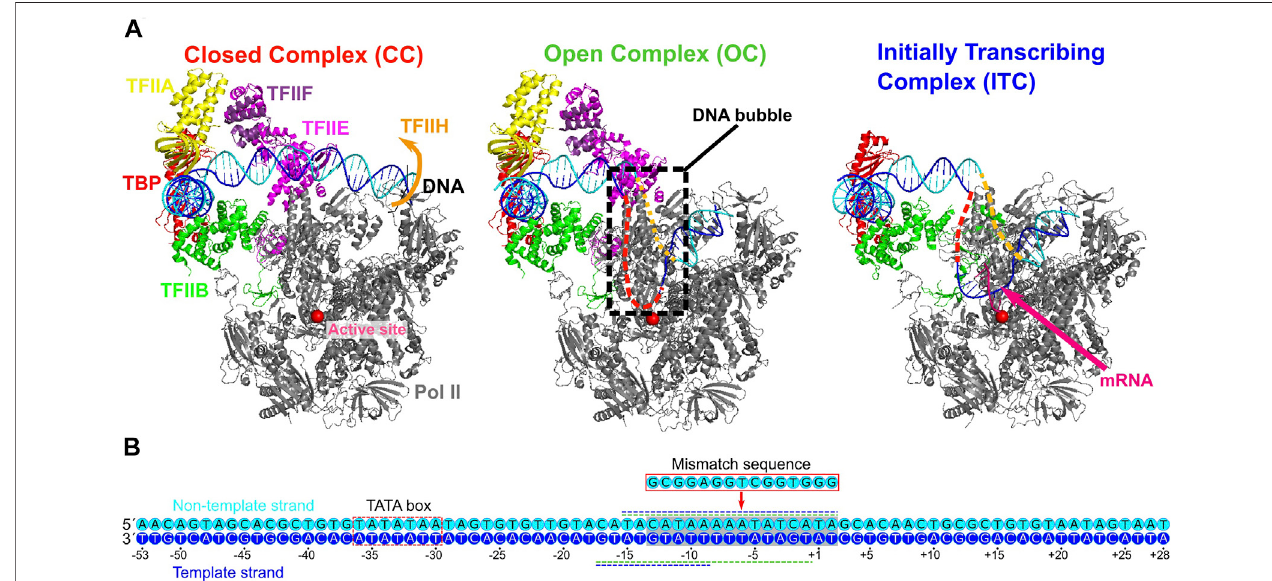
FIGURE 1 | Three yeast PICs of RNA polymerase II and the promoter sequence used. (A) The three PICs obtained by cryo-EM; the closed complex (CC) (PDB: 5FZ5) (left) ,theopencomplex(OC)(PDB:5FYW) (center) ,andtheinitiallytranscribingcomplex(ITC)(PDB:4V1N) (right) .TheCCandOCmodelscontainthepromoter DNA, Pol II, TBP, TFIIA, TFIIB, TFIIE, and TFIIF. The ITC model contains the promoter DNA, Pol II, TBP, TFIIB, and 6 bp nascent RNA. Parts of the melted DNA were not modeledintheOCandITCstates(Redandorangebrokenlines). (B) ThepromoterDNAsequenceusedinthecurrentstudy(numberedrelativetothetranscription starting site). The sequences are taken from those used in the cryo-EM studies of the OC and the ITC (Plaschka et al., 2016; Plaschka et al., 2015). Blue, the template DNAstrand;cyan,thenon-templateDNAstrand;reddashedsquare,TATAbox;graysquare,regiontowhichmismatchedsequenceisintroducedinasimulation;green and blue horizontal dashed lines along the sequence, the regions not appeared in the OC and ITC models by cryo-EM,